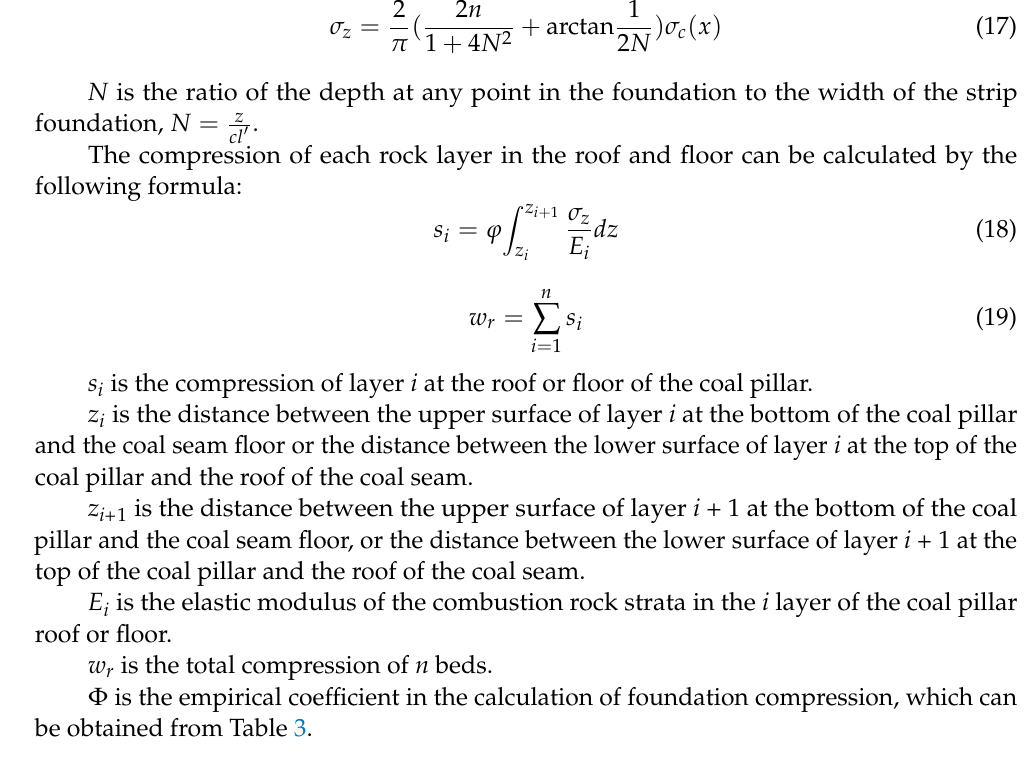
Table 3. Empirical coefficient of foundation compression calculation [42]. Elastic modulus of rock in foundation